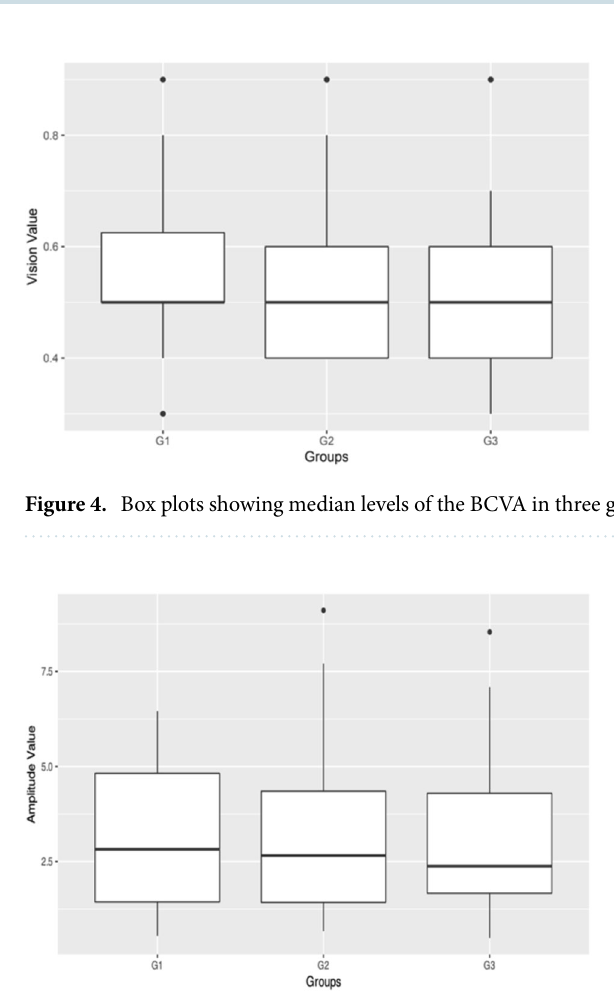
Figure 5. Box plots showing median levels of the amplitude in three groups of patients.